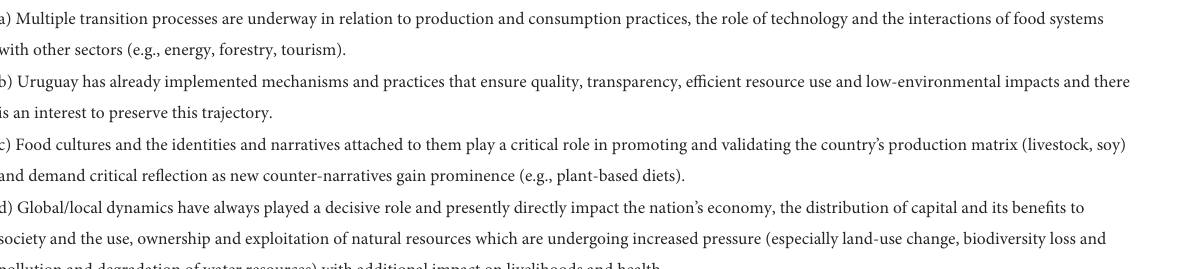
TABLE 6 Key points for sustainable food system transformations identified for the Uruguayan context. Key points for sustainable food system transformations for